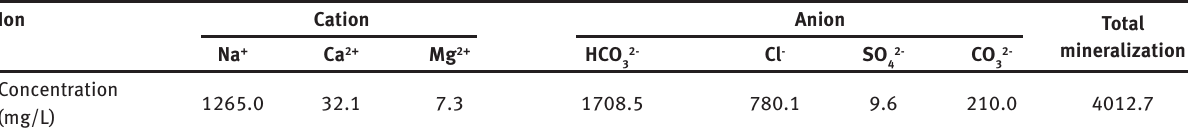
Table 1: Ions in